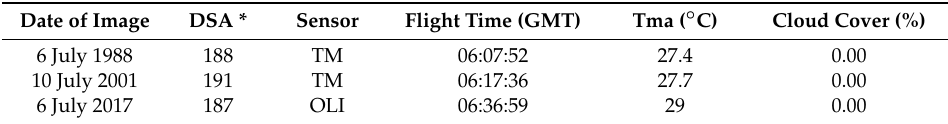
Table 2. Details of the Landsat TM/OLI images.